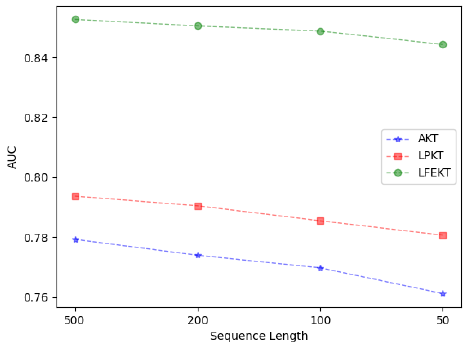
Figure 4. AUC at different sequence